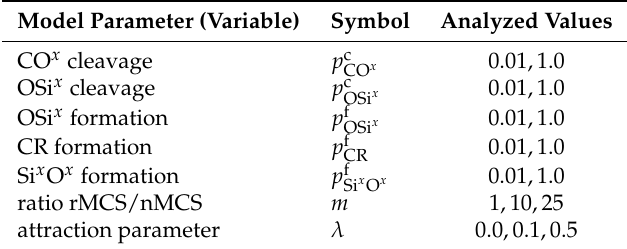
Table 1. All varied model parameters and corresponding analyzed values of the reactive bond fluctuation model are listed